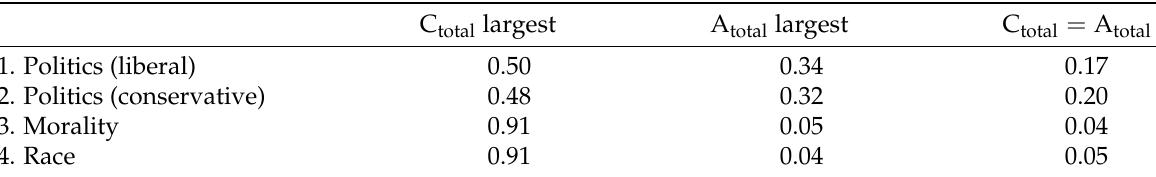
Table 5: Proportion of respondents for whom C total or A total estimates of total influence are